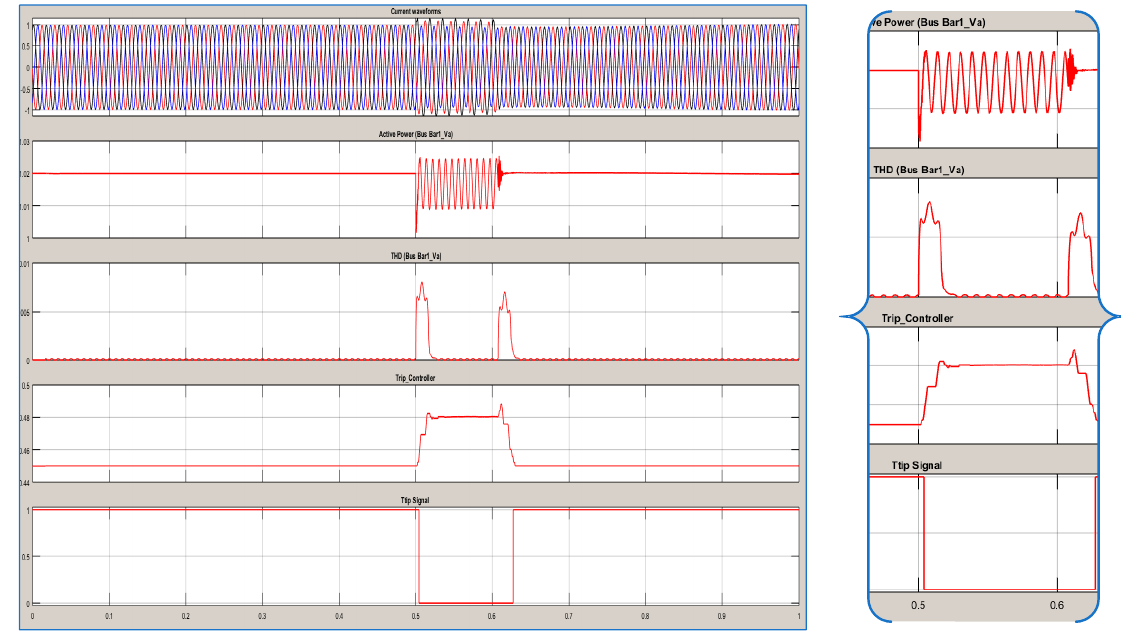
Figure 12. Single line to ground (B_G) fault current waveform.